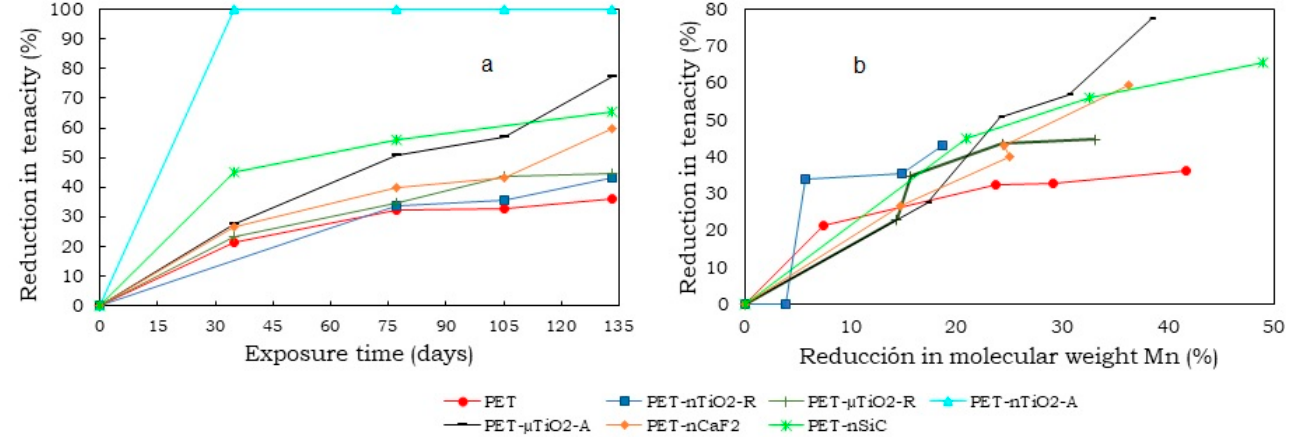
Figure 10. ( a ) Reduction in tenacity after 135 days in the climatic chamber and ( b ) Reduction in tenacity as a function of reduction in molecular weight.